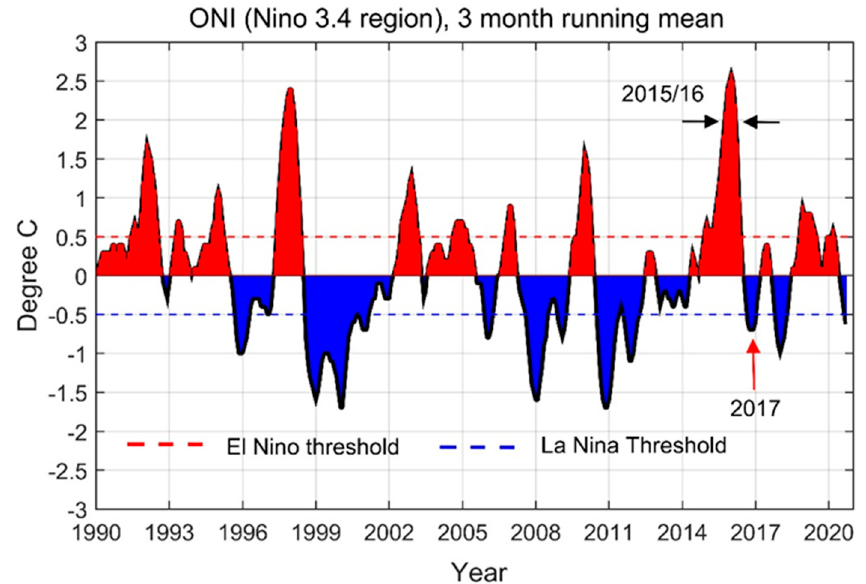
Figure 3. Time series of the ENSO index and SST anomalies in Niño 3.4 Region. Warm and cold periods are based on a threshold of +/ − 0.5 °C for the ONI (3 month running mean of SST anomalies in the Niño 3.4 Region) and represented by red and blue colors, respectively. Dotted lines represent standard deviations of the series. The 2015–2016 El Niño was the first powerful El Niño of the 21st century and one of the three strongest El Niño events since 1950.